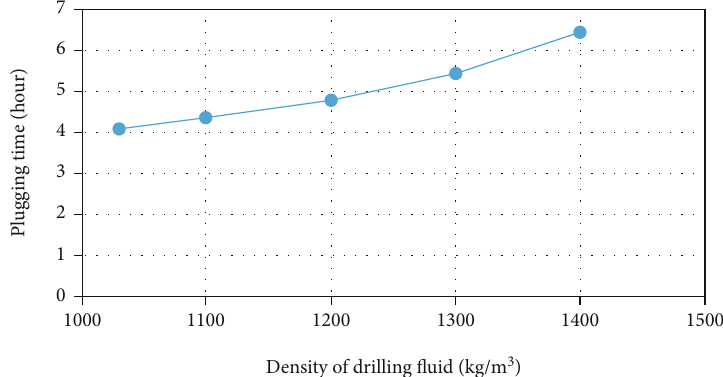
Figure 12: Plugging time versus density of drilling fl